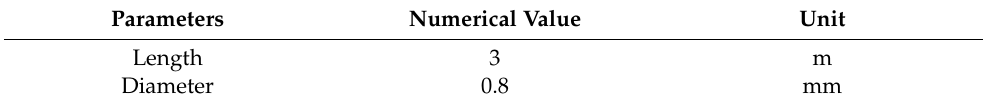
Table 6. The dimensional parameters of the waveguide